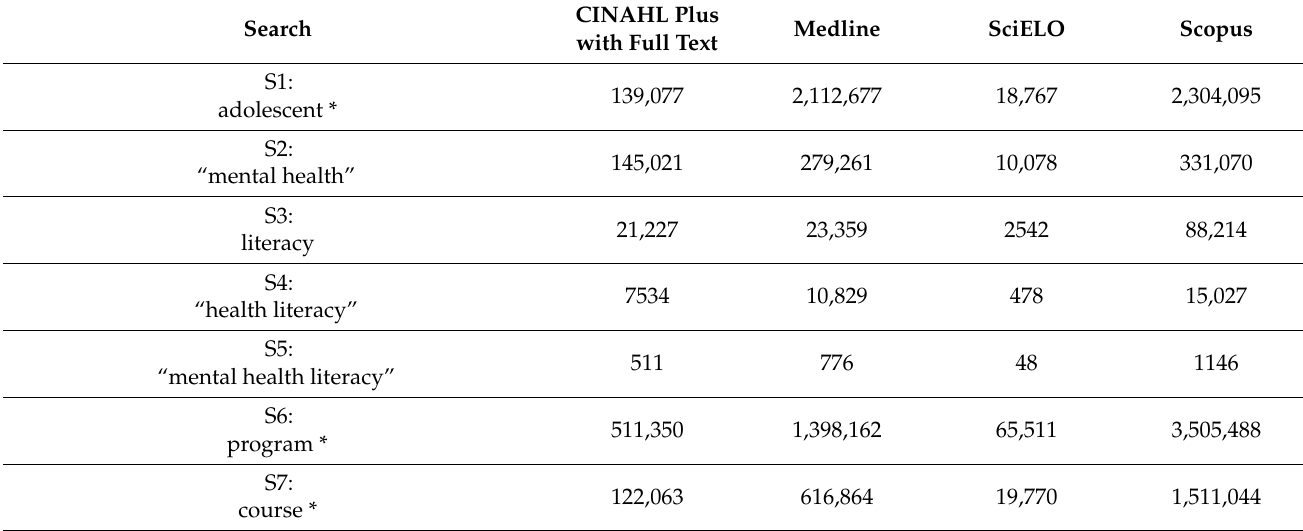
Table 1. Studies obtained by search term and electronic